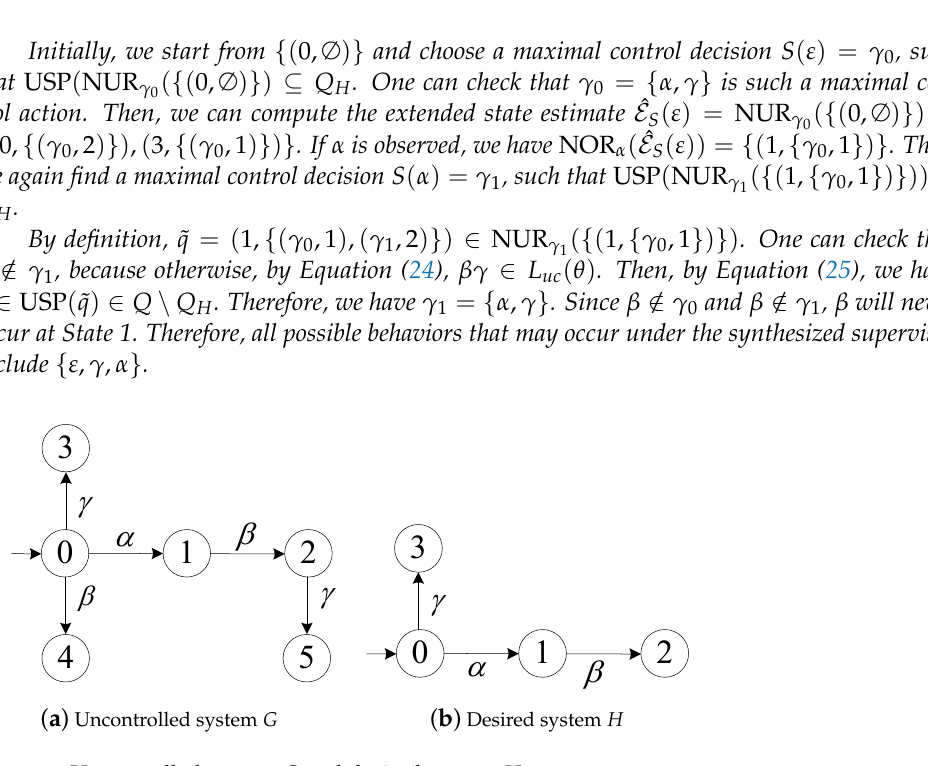
Figure 6. Uncontrolled system G and desired system H